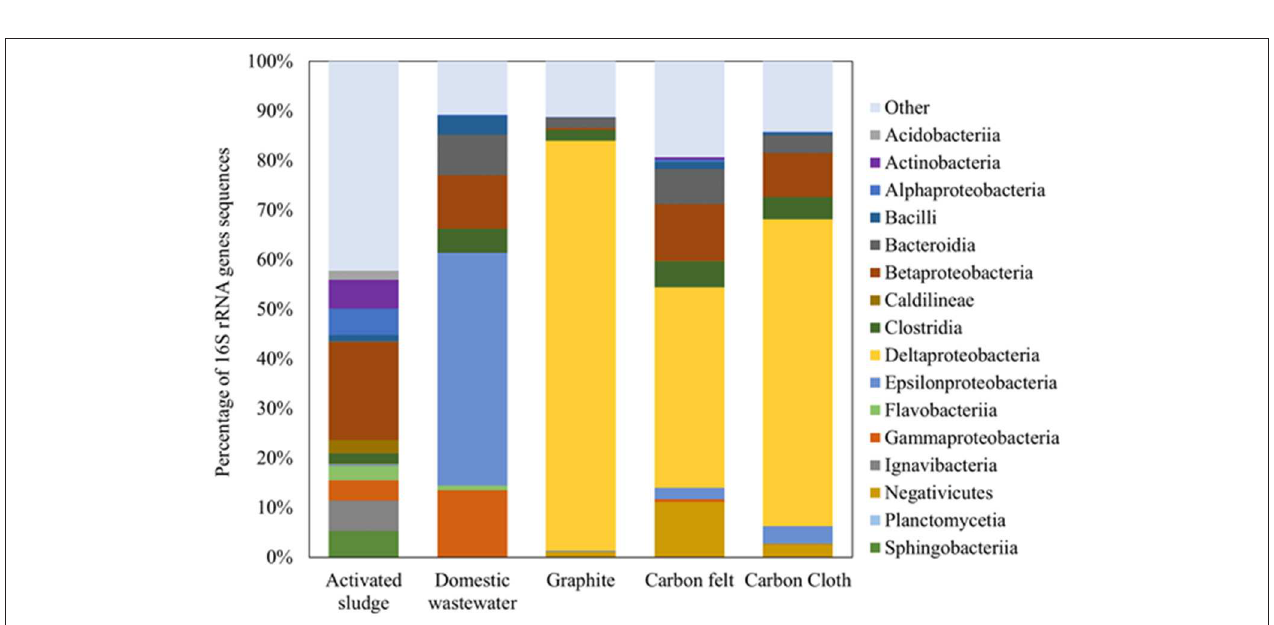
FIGURE 4 | Relative abundance of major bacterial classes identified in the activated sludge, the domestic wastewater and in biofilms developed after 24 days on G3, CF, and CC.